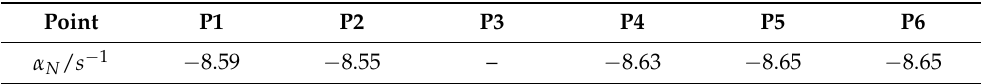
Table 4. The decay coefficient of different monitoring points.